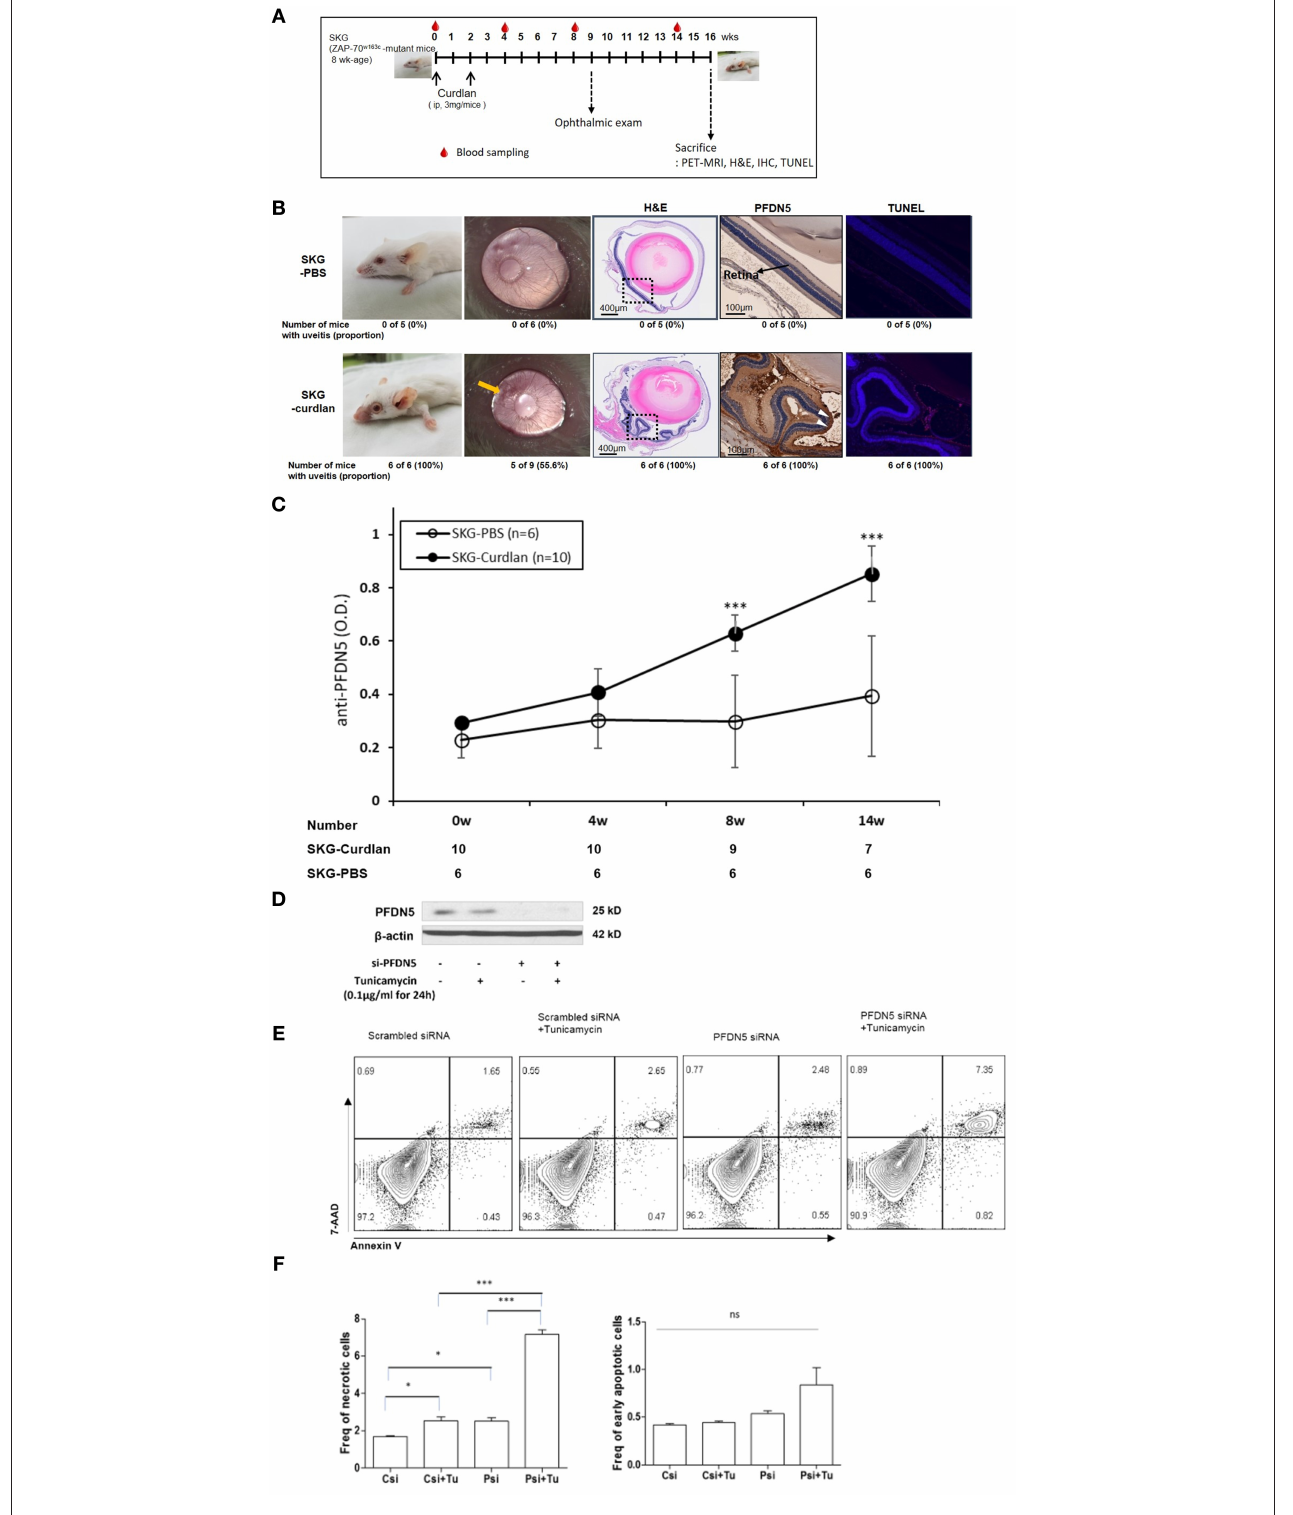
FIGURE 2 | Expression of PFDN5 in curdlan-treated SKG mice with ocular lesions, and the role of PFDN5 against apoptosis in ARPE19 cells. (A) The experimental design. (B) Comparison of gross phenotype, microscopic ophthalmologic exam, H&E staining, IHC, and TUNEL assay between PBS-treated SKG mice and curdlan-treated-SKG mice. (C) ELISA analysis of anti-PFDN5 antibody levels in sera of PBS-treated SKG mice and curdlan-treated SKG mice according to the number